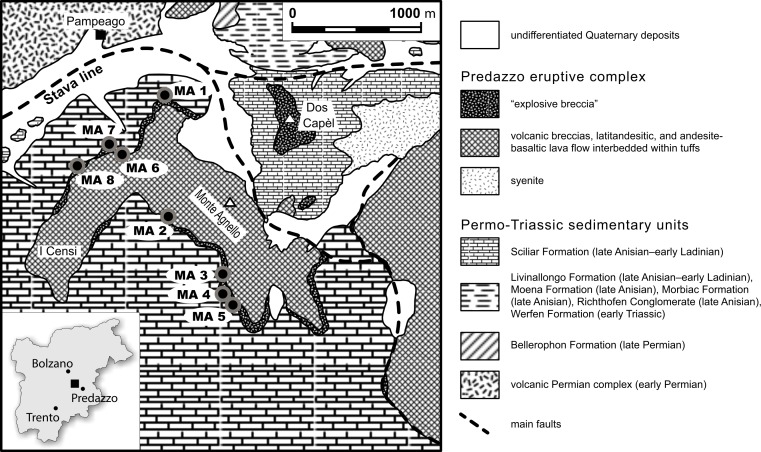
Simplified geological map of the Monte Agnello area (Dolomites, N-Italy), modified from Vardabasso (1930). MA1–MA8, fossil sites.